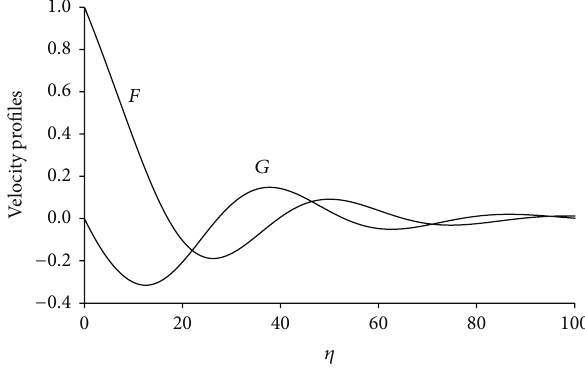
Figure 1: Velocity profiles, 𝛽 = 20 , 𝑚 = 10 , 𝑛 = 1.2 , and 𝑉 𝑠 = 20 .